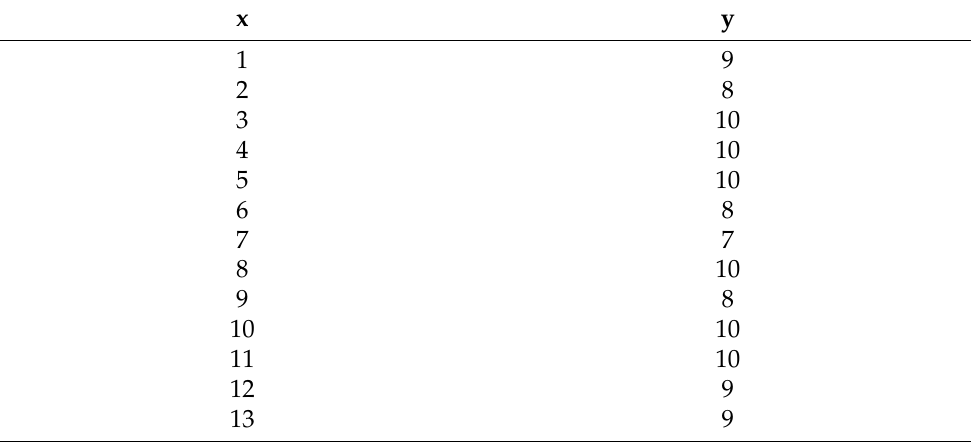
Table 5. Sales data by